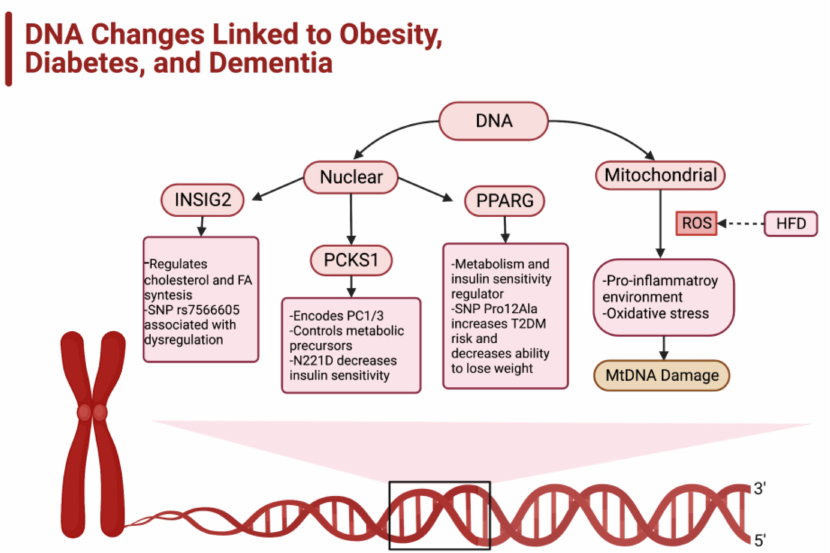
Figure 4. Genetic predisposition for development of obesity. The predisposition for the development of obesity is dictated by several genes, both nuclear and mitochondrial. The nuclear genes insulin- induced gene 2 (INSIG2), proprotein convertase subtilisin/kexin type 1 (PCKS1), and peroxisome proliferator-activated receptor gamma (PPARG) play a role in metabolism regulation. Mutations or single nuclear polymorphisms (SNPs) cause the dysregulation of these genes and thus awry metabolic function that can stimulate the development of